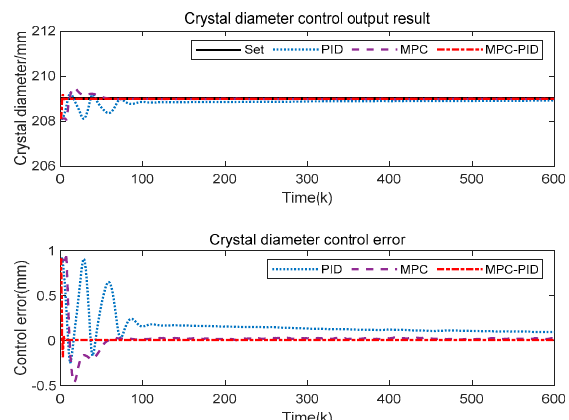
Figure 9. Crystal diameter control output results.